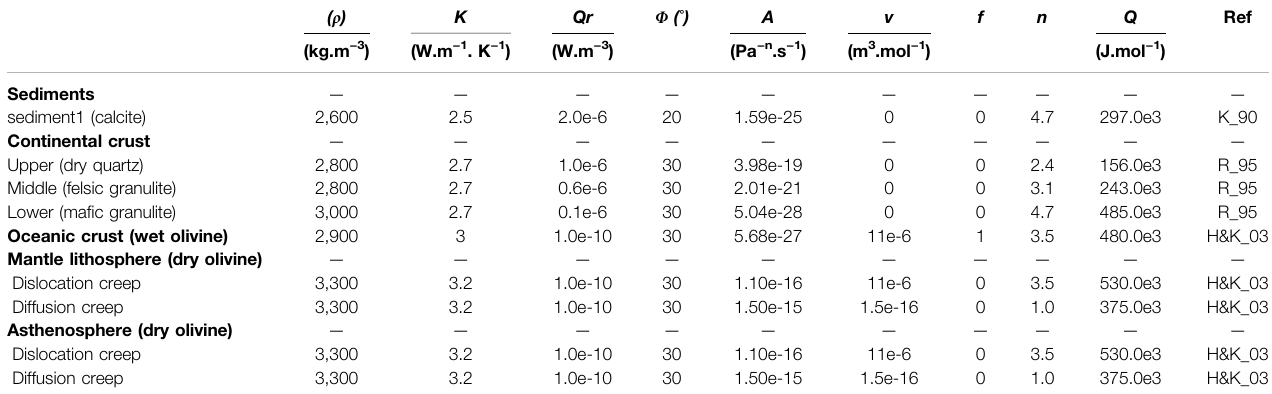
TABLE1| Rheologicalandthermalparametersusedforthereferencenumericalmodels.Here ρ isthedensity, k isthethermalconductivity, Q r istheradiogenicheatproduction, ϕ is the friction angle, A is a pre-factor, f is a correction factor, n is the stressexponent, Q isthe activation energy. The shear modulus G isset to6e 10 10 Pa. Referencesfor rheology are H&K_03: Hirth and Kohlstedt (2003); K_90: Kronenberg et al. (1990); R_95: Ranalli